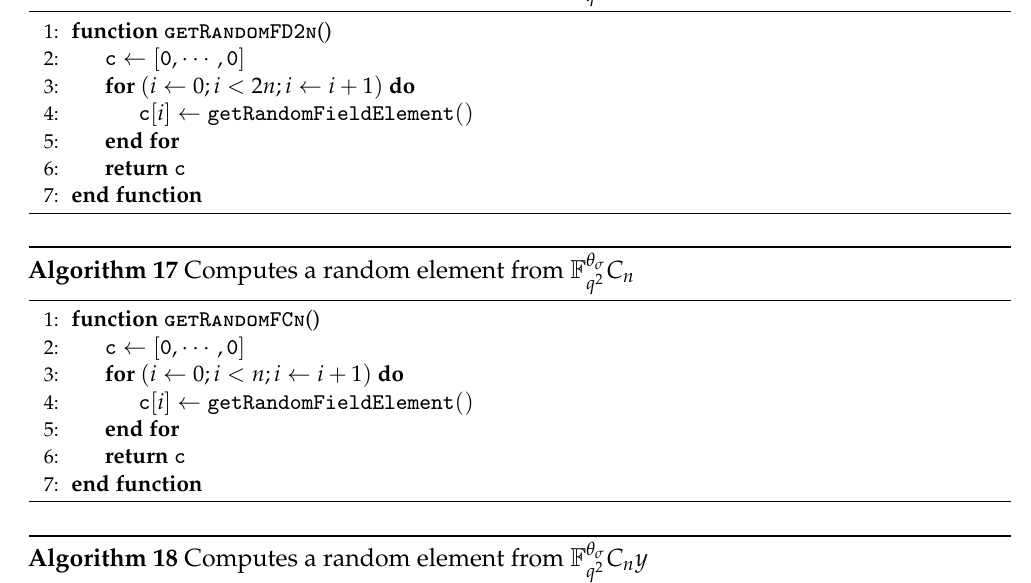
Algorithm 16 Computes a random element from F θ σ